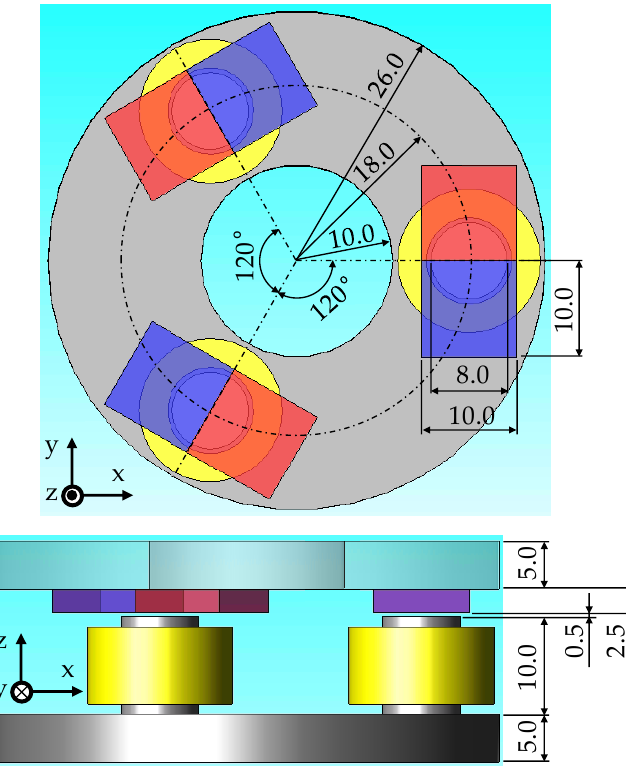
Figure 2. The main dimensions of the proposed 2-DOF LRA.